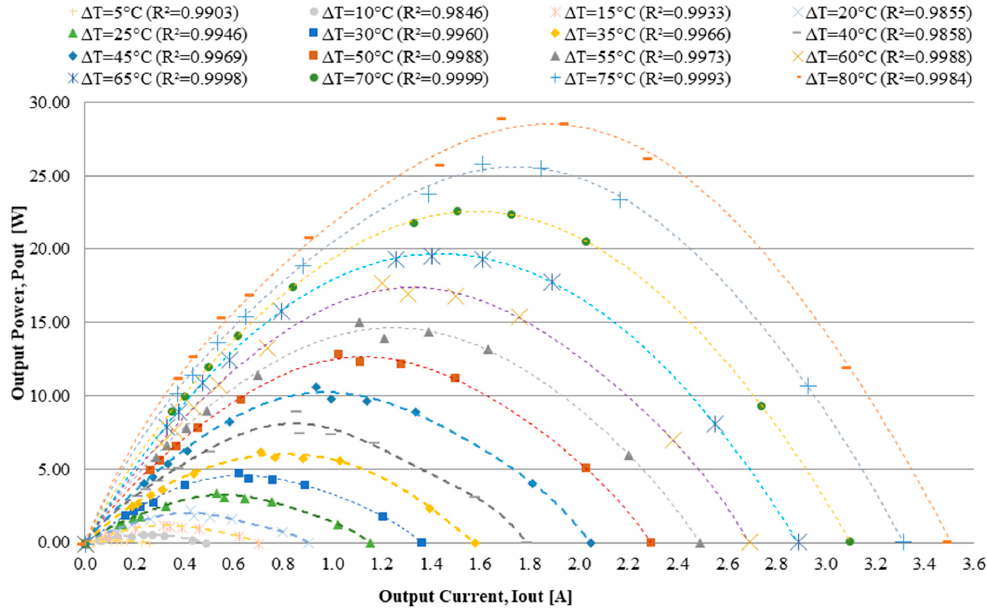
Figure 6. Output power–output current curve.